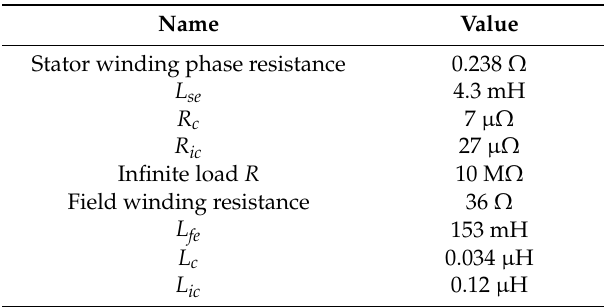
Figure 5. External circuit of field-circuit coupled FE application model. ( a ) Stator winding circuit; ( b ) Rotor field winding circuit; ( c ) Rotor damper winding circuit of one pole and inter-pole connection. Table 2. External circuit